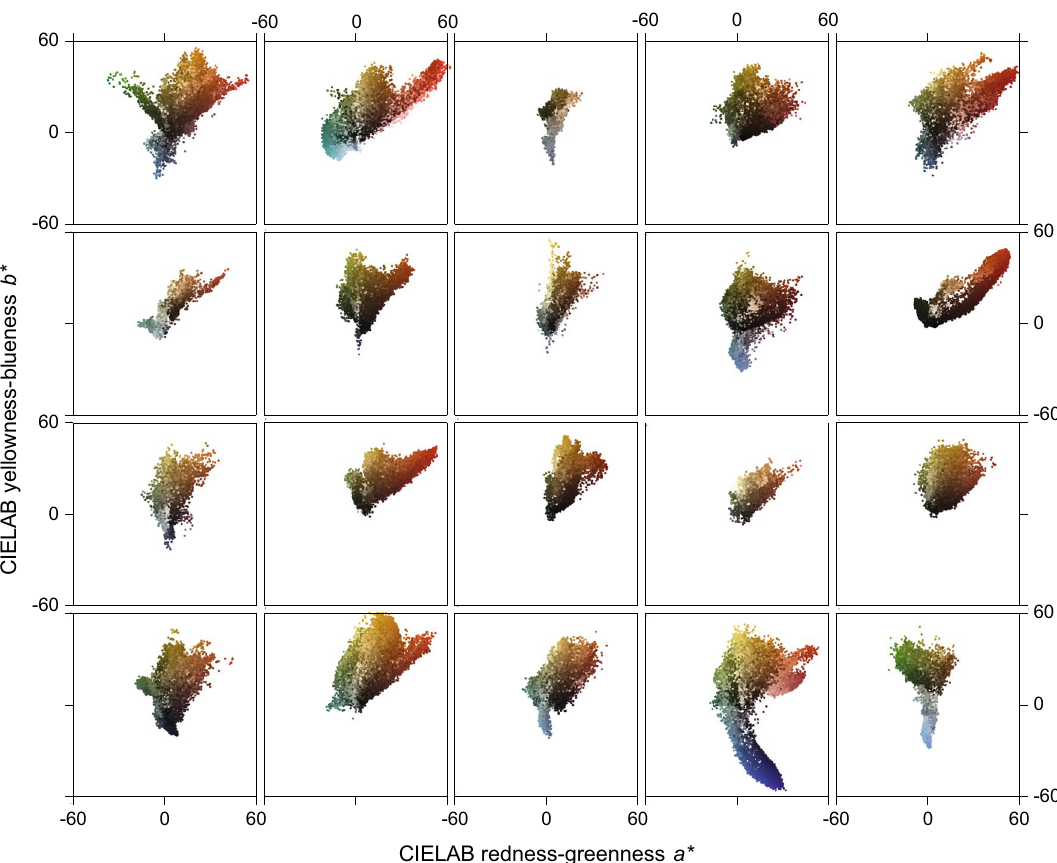
Figure 4. Color gamuts of painting images in Fig. 1. Each plot shows the CIELAB 17 chromaticity coordinates ( a * , b * ) of pixels drawn uniformly from the corresponding image in Fig. 1, which has the same row-column layout. Only about 1% of pixels are plotted to more clearly reveal density